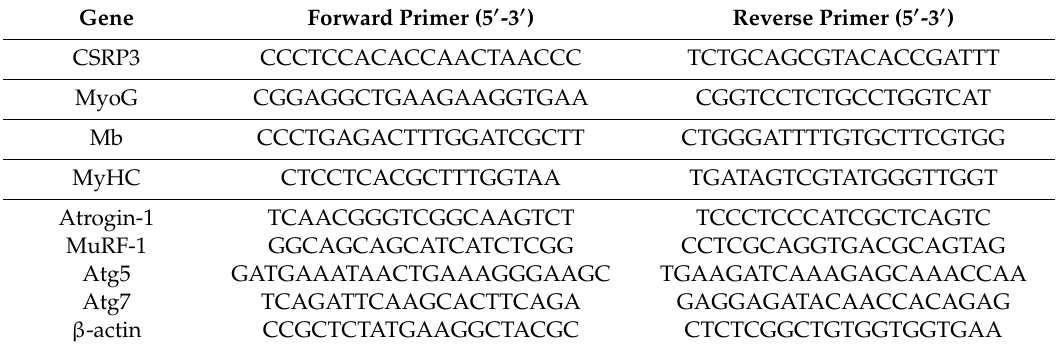
Table 1. Gene-special primers for